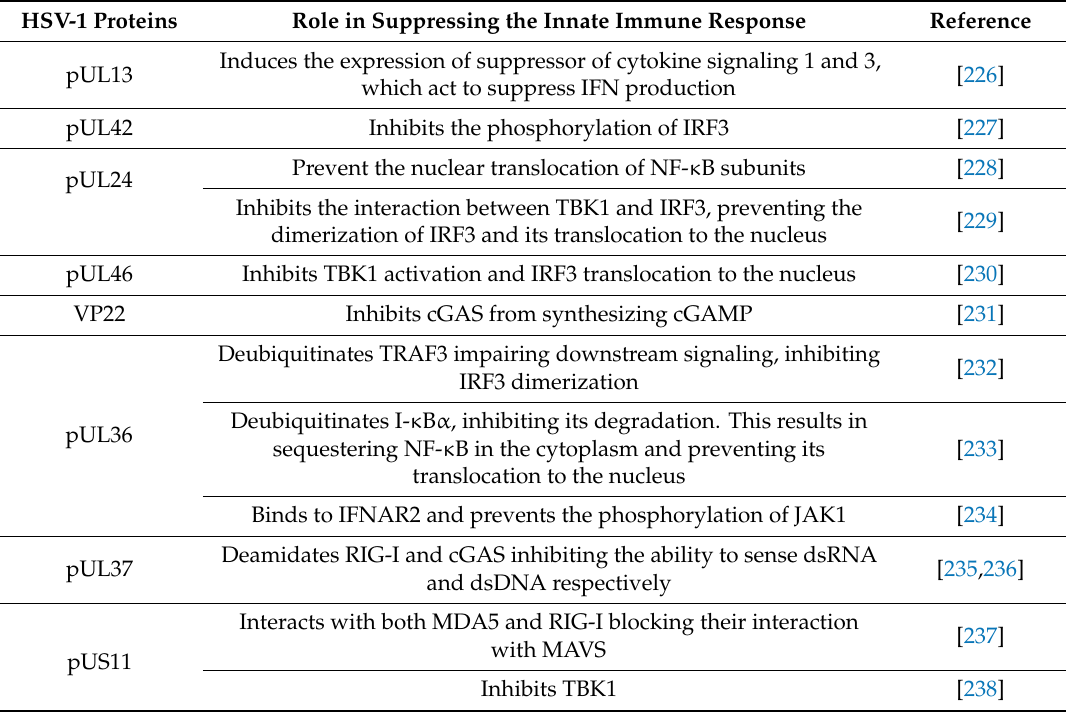
Table 3. Minor viral proteins involved in immune